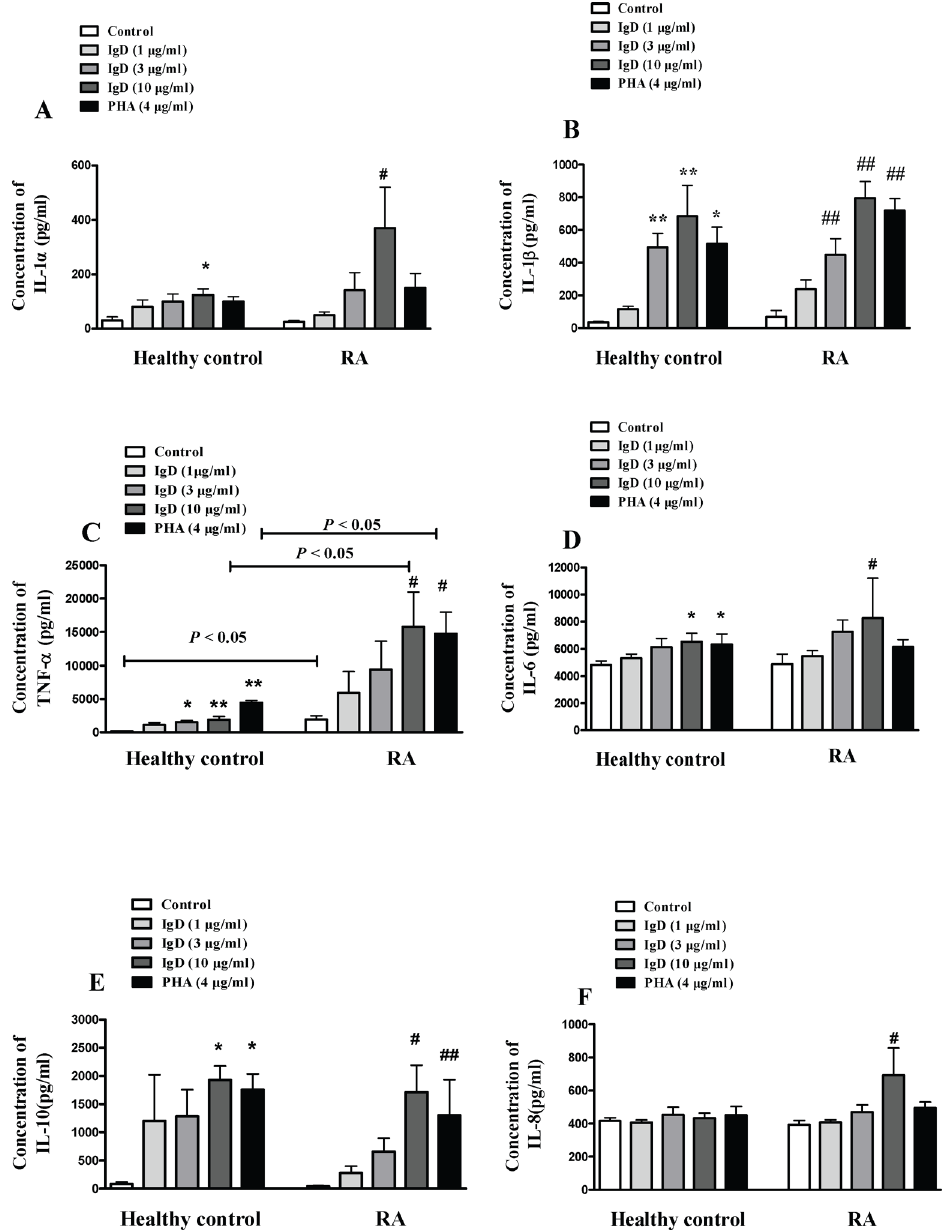
Fig 5. The effect of IgD on levels of inflammatory cytokines in PBMCs culture supernatant. PBMC culture supernatants were collected from RA patients and healthy controls and treated with IgD (1, 3, or 10 μ g/ml) or PHA (4 μ g/ml) for 24 h. Levels of IL-1 α (A), IL-1 β (B), TNF- α (C), IL-6(D), IL-10 (E) and IL-8(F) were measured by microarray scanner as described in the Materials and Methods. Data represent the mean ± standard error of the mean (n = 4). * P < 0.05, ** P < 0.01 vs . the control from healthy controls; # < 0.05, ## P < 0.01 vs . the control from